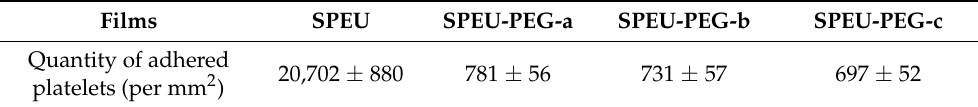
Figure 8. Representative SEM micrographs of platelet adhesion on the film surface of ( a ) SPEU; ( b ) SPEU-PEG-a; ( c ) SPEU-PEG-b; and ( d ) SPEU-PEG-c. Table 3. Quantification of platelets adhering to the blank and MPC-grafted PEU